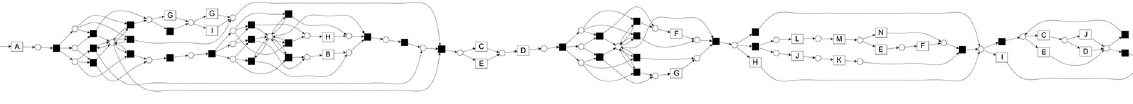
PLOS ONE | https://doi.org/10.1371/journal.pone.0281836 February 23, 2023 19 /